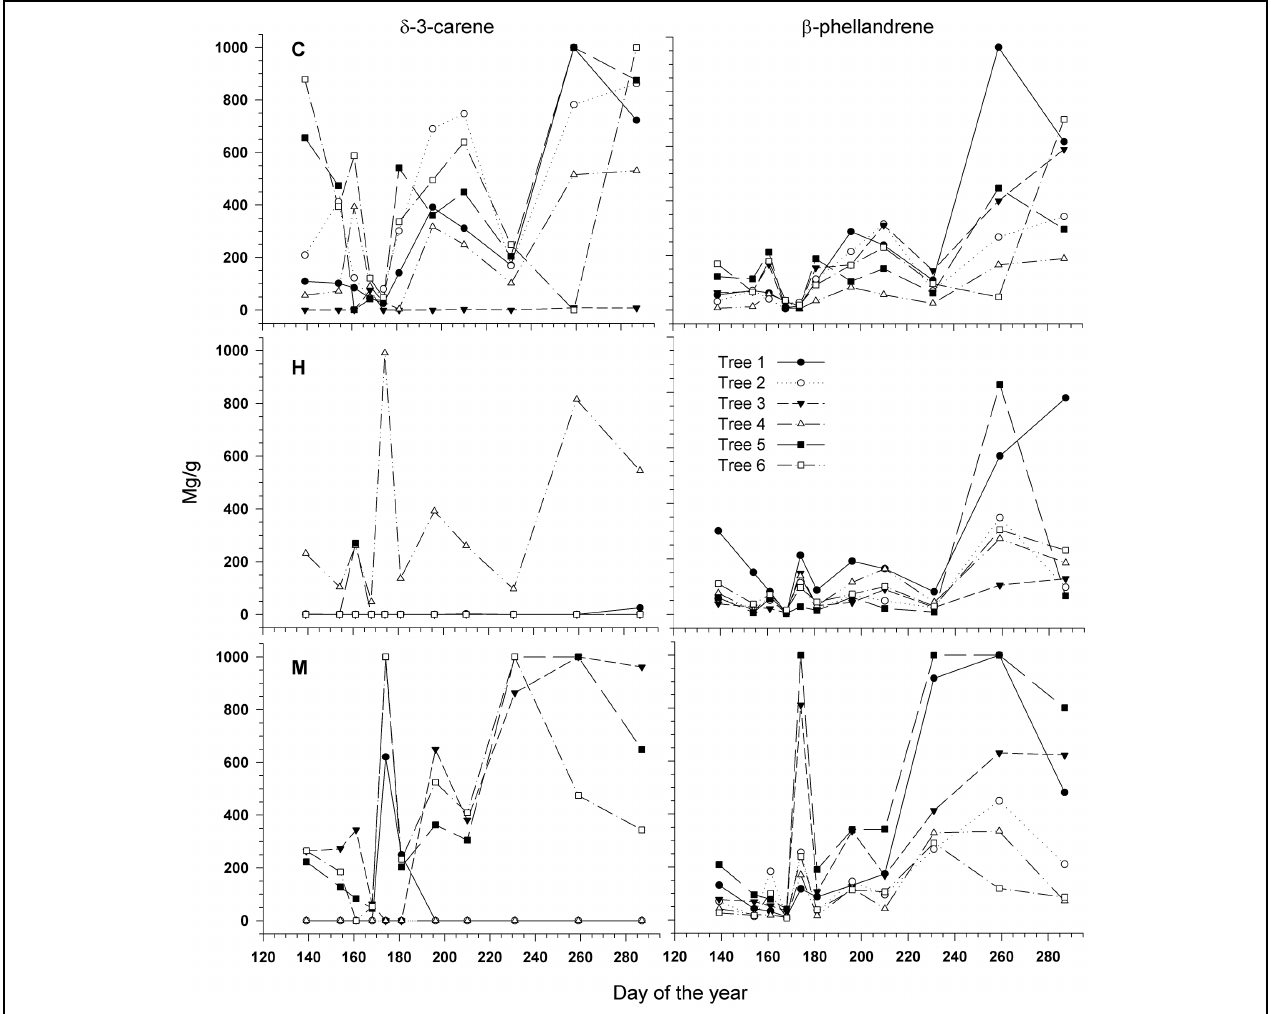
FIGURE 7 | Quantity (mg/g dw ) of δ -3-carene (Left) and β -phellandrene (Right) measured during the growing season in six trees per defoliation intensity (C, control trees; M and H are moderately and heavily defoliated trees). All the trees (numbered from 1 to 6 for each intensity) are represented because of the big difference between trees, especially for heavily defoliated